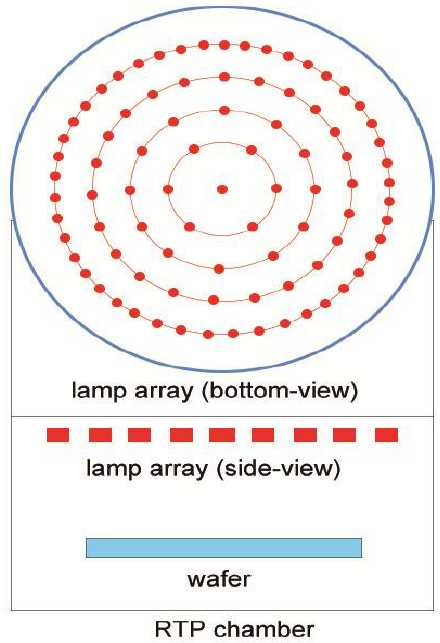
Figure 1. A simplified schematic of the rapid thermal processing (RTP) chamber. The lower frame: side-view of the RTP chamber, including a silicon wafer and a tungsten–halogen lamp array; the upper frame: bottom-view from the wafer for the configuration of the concentric tungsten–halogen lamps.